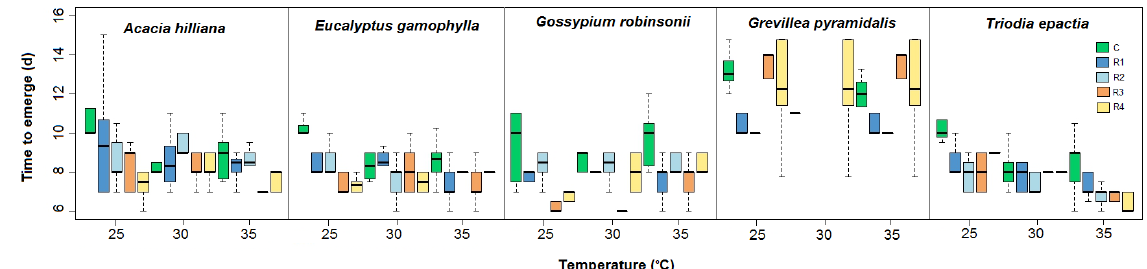
Figure 2. Mean time to emergence (days, mean ± SE, n = 12) of Pilbara native plant species under climate scenarios (temperature and rainfall). Watering treatments (C, R1, R2, R3 and R4) as described in Table